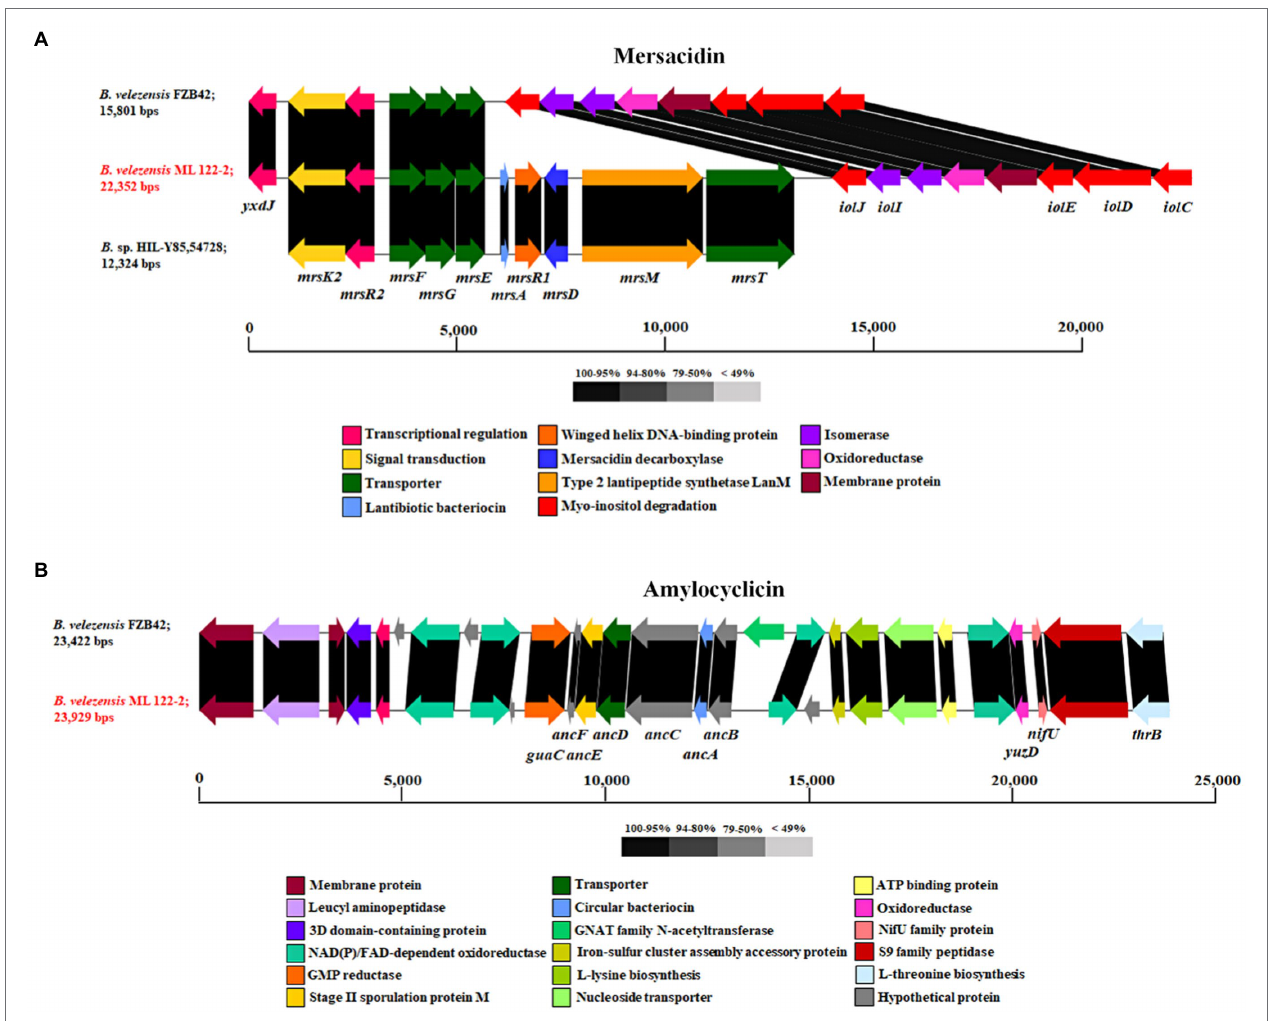
FIGURE 2 | Schematic image of the gene clusters associated with the ribosomally synthesized peptides, Mersacidin (A) and amylocyclicin (B) of strains B. velezensis ML122-2 (red), B. velezensis FZB42 and B. sp. HIL Y-85,54,728. Predicted functions and sequence similarity are color-coded as